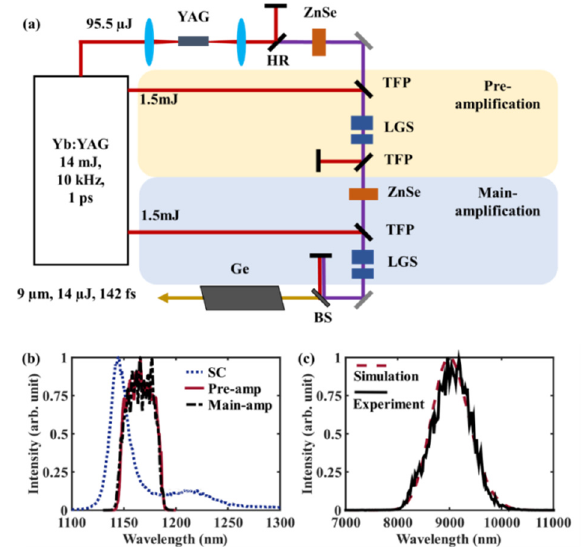
Figure 14. ( a ) The schematic of the 9 μ m OPCPA. YAG, Yttrium aluminum garnet; ZnSe, zinc selenide window; HR, high reflective mirror; TFP, thin film polarizer; BS, beam splitter; LGS, LiGaS 2 crystal; Ge, germanium window. For TFP, the reflectance of the S-polarized pump and the transmittance of the P-polarized signal were measured as > 99% and 91% respectively. ( b ) The spectra of signal pulses after SC generation (blue dotted), the pre-amplification stage (red) and the main-amplification stage (black dashed); ( c ) the measured (black) and simulated (red dashed) spectra of the output idler pulse. Reprinted with permission from [56].